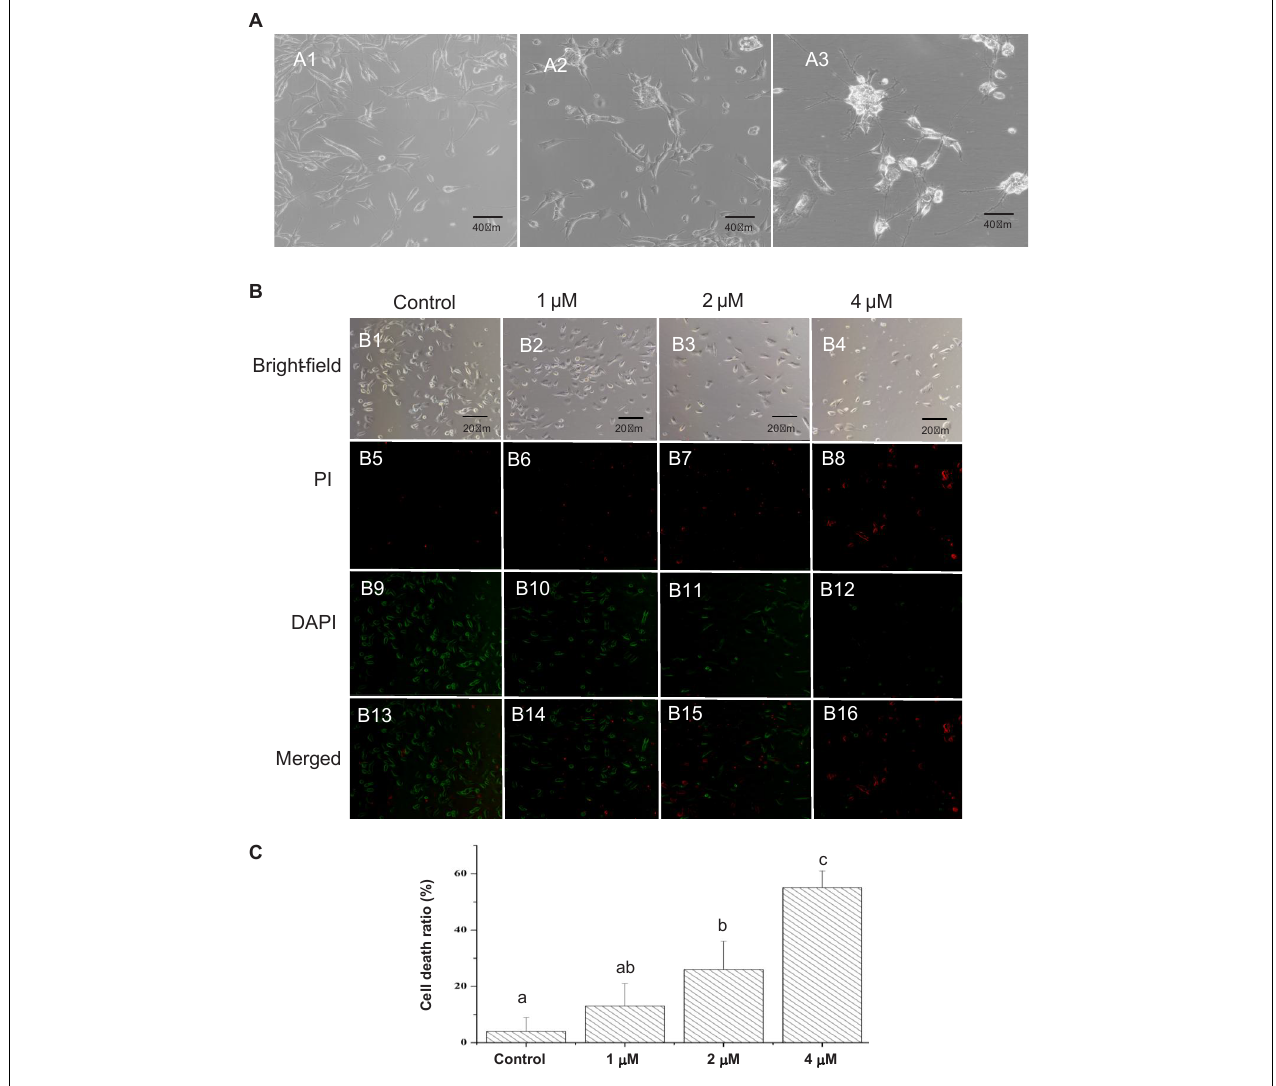
FIGURE 1 | Characteristics of cultured SH-SY5Y cells and effects of A β 1 - 42 on death of SH-SY5Y cells. (A) Morphology of SH-SY5Y cells at different differentiation stages observed using an Axiovert inverted microscope. A1, untreated SH-SY5Y cells ( × 200 magnification). A2, SH-SY5Y cells treated with ATRA for 5 days ( × 200 magnification). These cells demonstrated an increased death rate and a more polar morphology, as cell bodies extended longer and networks began to form. A3, after further maturation with BDNF, the cells migrated to clusters and networks became increasingly complex ( × 200 magnification). (B) The SH-SY5Y cells were treated with different concentrations of A β 1 - 42 for 24 h, the cell death rates were determined by comparing the number of dead cells to the number of total cells in the images ( × 200 magnification). (C) Quantification of cell death ratios after 24 h treatment with the indicated concentrations of A β 1 - 42 . The different letters indicated a significant difference between experiment groups at p < 0.05 (Duncan’s new multiple range test).